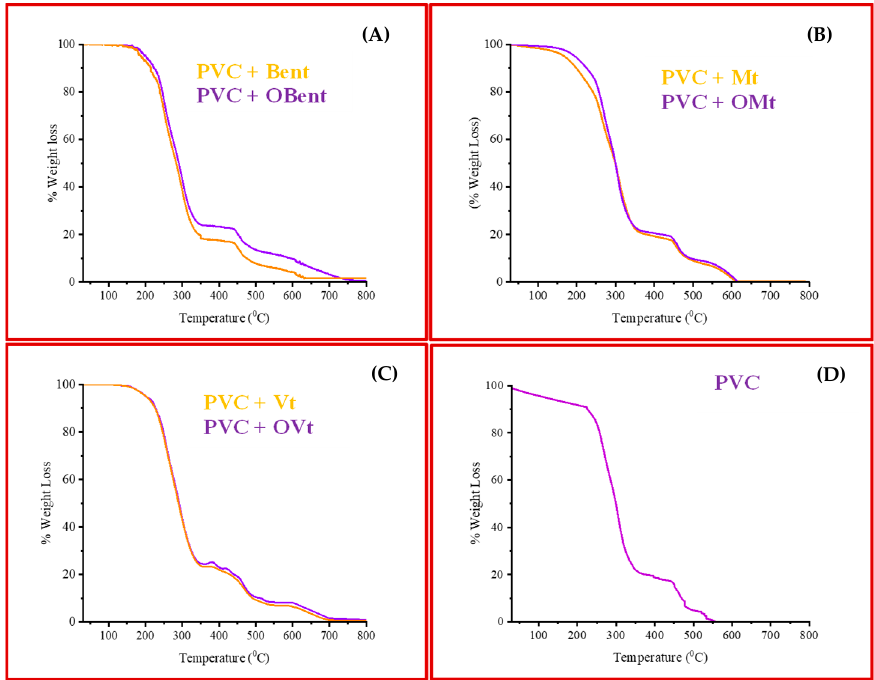
Figure 7. Thermogravimetric analysis (TGA curve) of ( A ) Mt, OMt-based PVC polymer composite, ( B ) Bent, OBent PVC polymer composite film, ( C ) Vt, OVt PVC polymer composite film and ( D ) pure PVC polymer film.